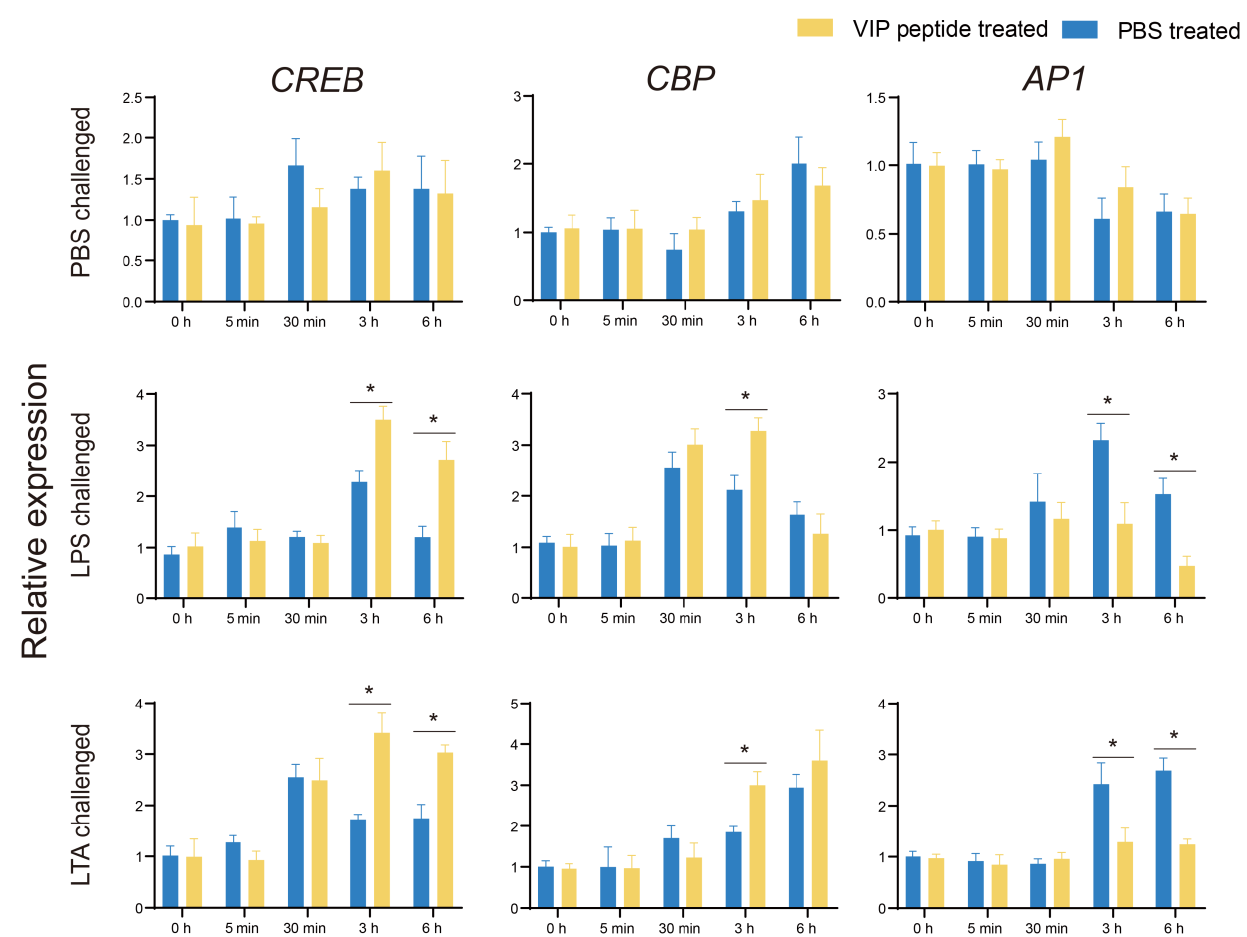
Figure 6. The expression profiles of cAMP-PKA pathway-related factors ( CREB , CBP , and AP1 ) af- ter LPS and LTA challenges of tilapia MO/MΦ were detected using qRT-PCR. Every value is presented as the mean and standard deviation; n = 3. The asterisks reveal the significant difference ( p < 0.05).